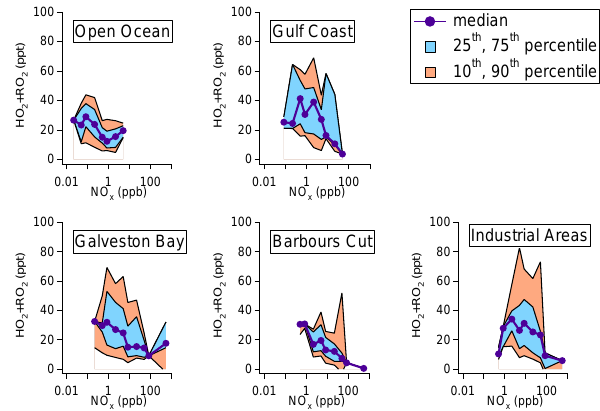
Fig. 6. Day-time measurements of HO 2 + ΣRO 2 vs. NO x at different locations during the R/V Brown cruise.